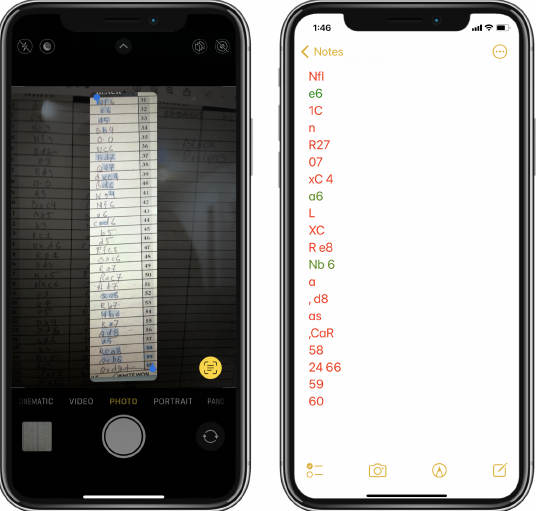
Figure 14. Demonstration of the Live Text feature in iOS 15 with an iPhone [31]. The left image shows the Live Text detection on a column of a test scoresheet, and the right image shows the predicted outputs. The correct predictions are colored green and the incorrect predictions in